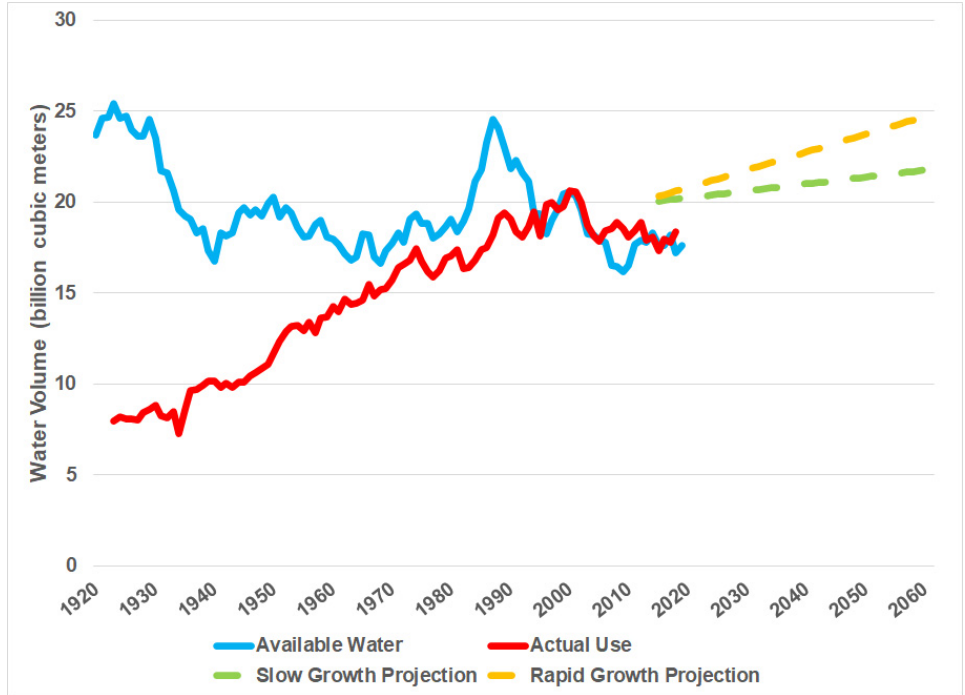
Figure 1. Historical traces of available water and actual use shown here refer to the natural supply of surface water from the Colorado River and the consumptive use of that water over time. The Colorado River Basin Water Supply and Demand Study conducted by the US Bureau of Reclamation in 2012 included water demand forecasts through 2060, based upon scenarios ranging from slow to rapid population growth [2]. It is now evident that this demand forecasting did not adequately account for recent downward trends in water consumption (historical estimates of available water and total consumptive use from US Bureau of Reclamation [3]).